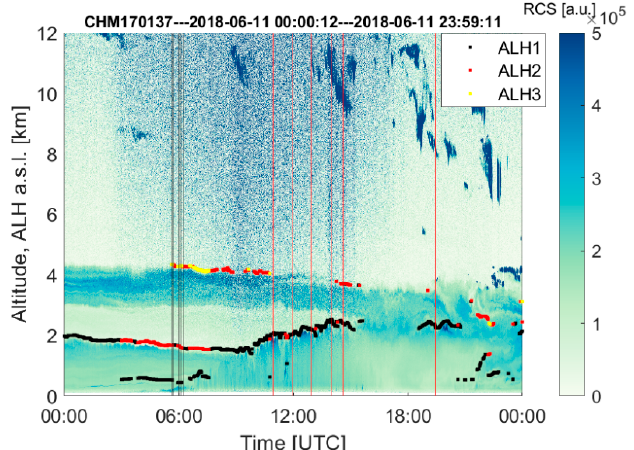
Figure 10. RCS for 11 June 2018 with overlaps of ALH. The vertical black lines delimitate the middle of 15 min intervals where warnings were automatically issued from our algorithm, while the vertical red line shows the middle of a ~1 h measurement interval by lidar.